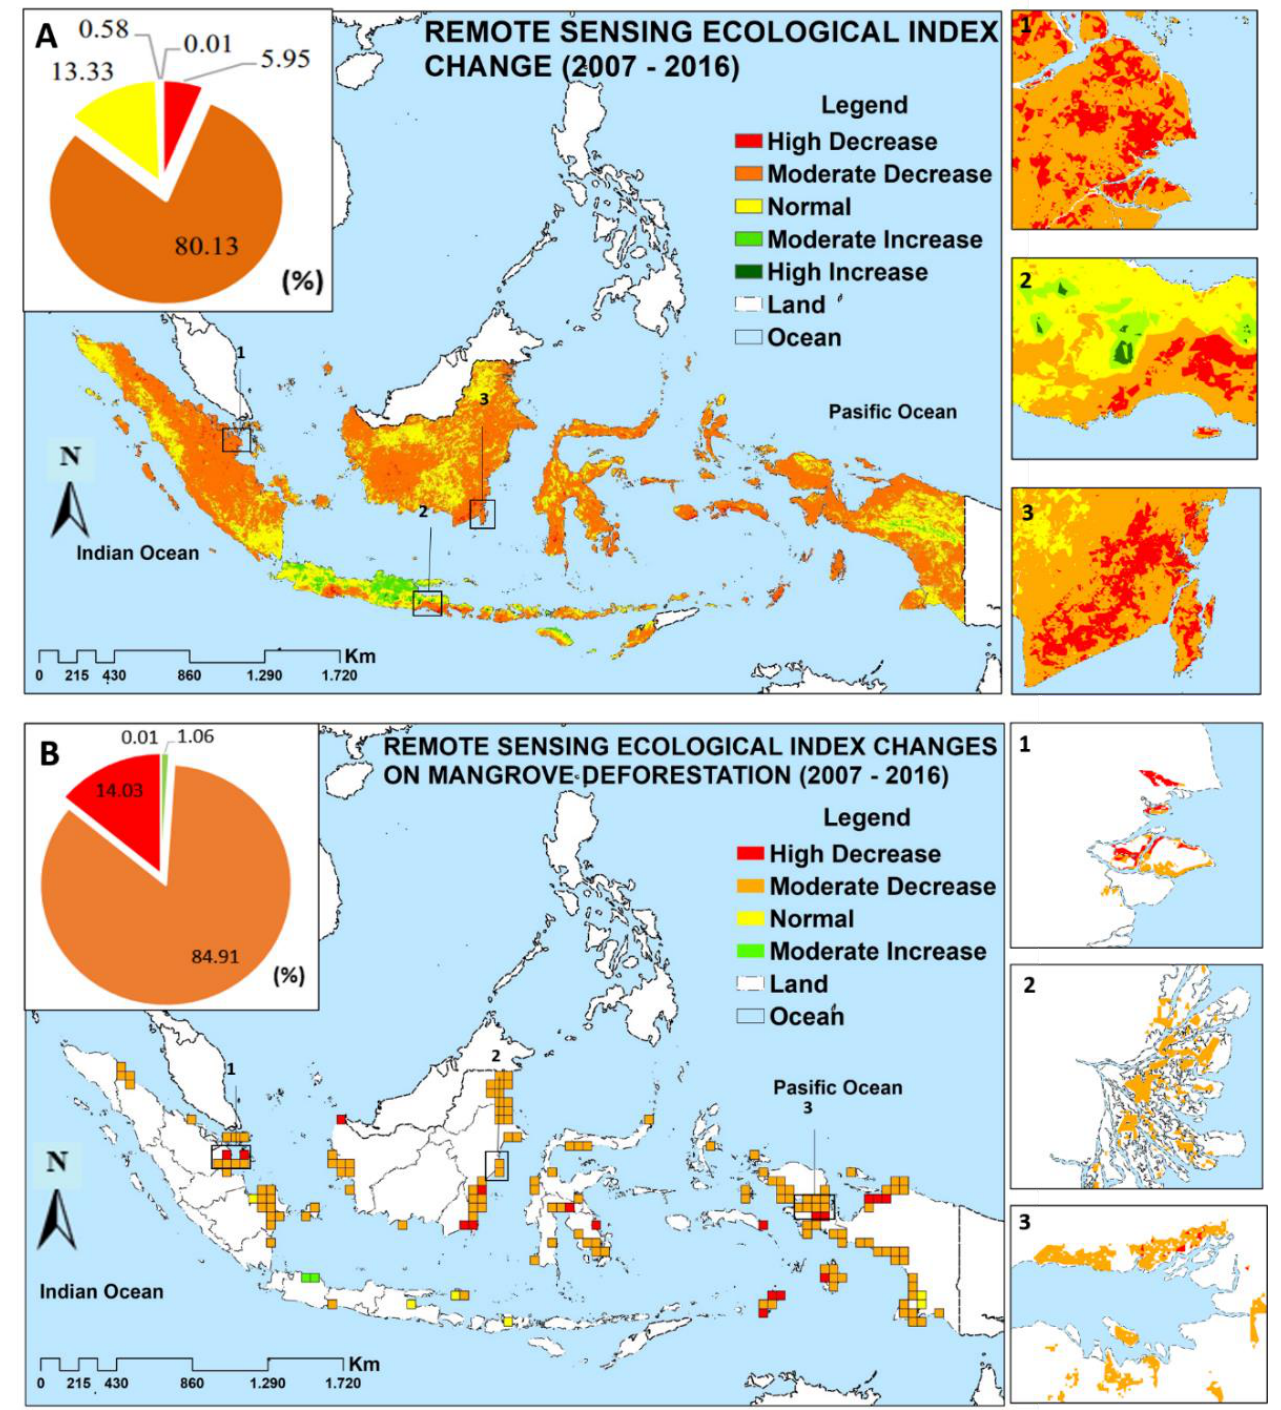
Figure 13. Changes in Indonesia’s remote sensing ecological index (RSEI) using the MODIS data product during 2007–2016 with a grid visualization of 1 km. ( A ) Changes in the RSEI in all regions of Indonesia; ( B ) changes in the RSEI in deforested mangrove areas.